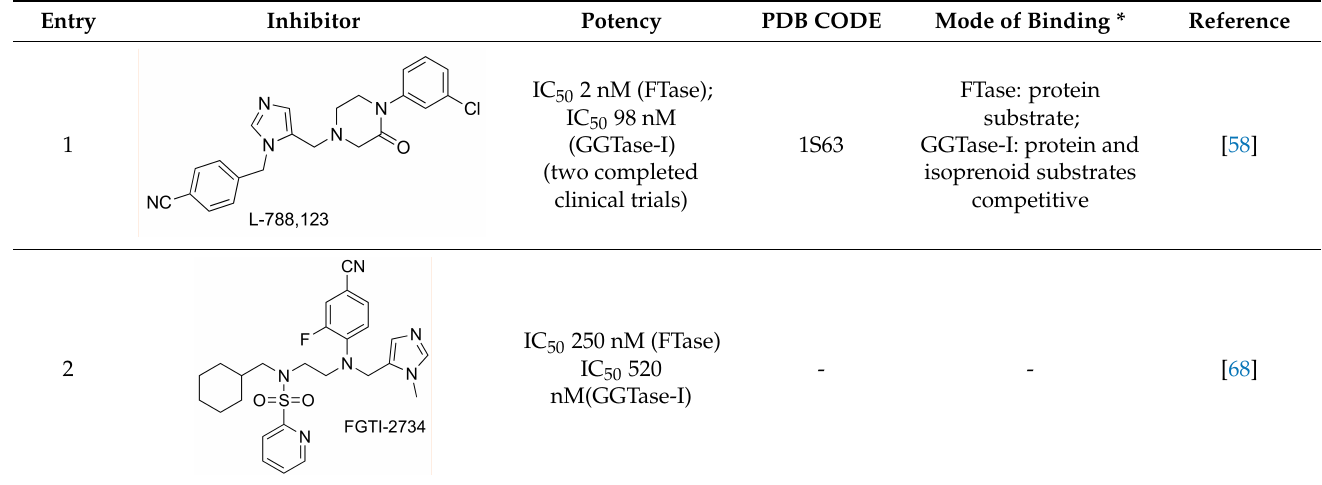
Table 4. Selected dual inhibitors of FTase and GGTase-I.